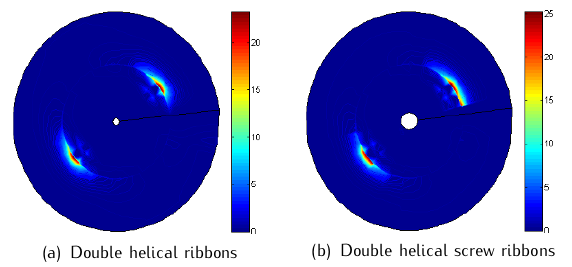
Figure 10. Dissipation rate induced in r-